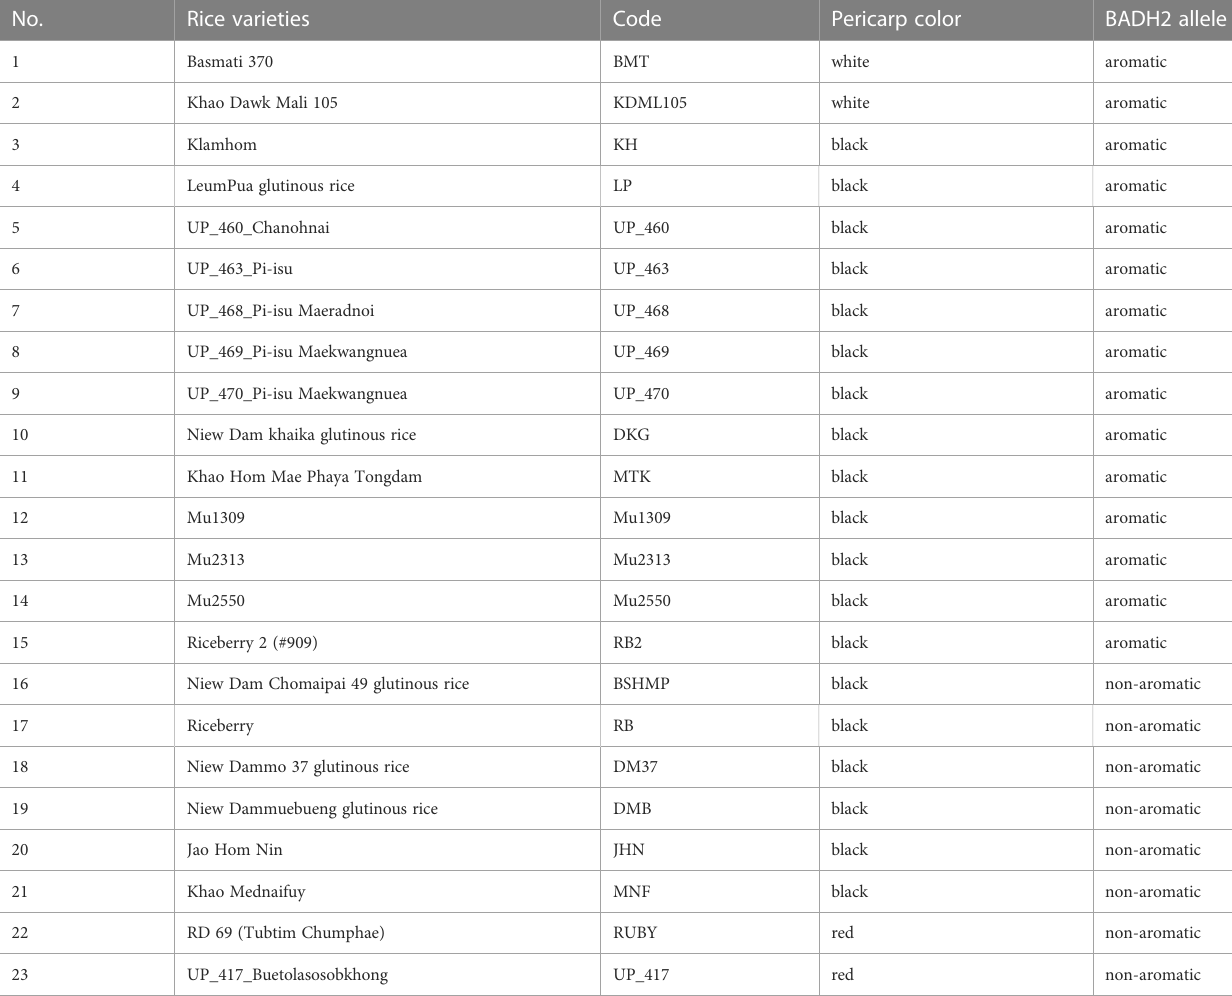
TABLE 1 List of rice